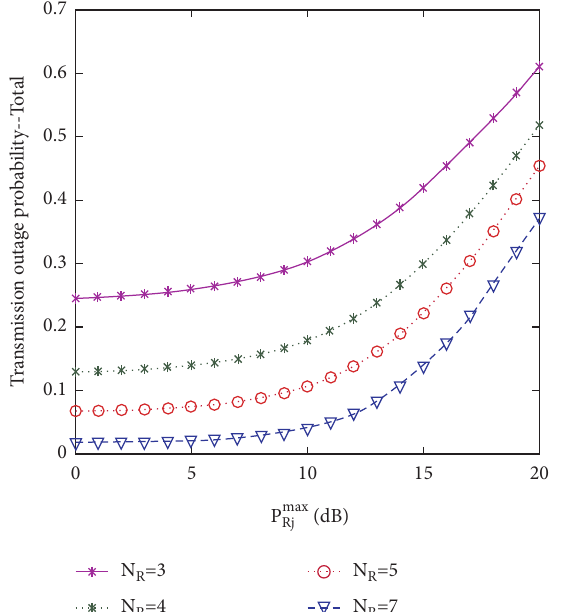
Figure 19: Total transmission outage probability versus P max � 10 dB , and P P R k